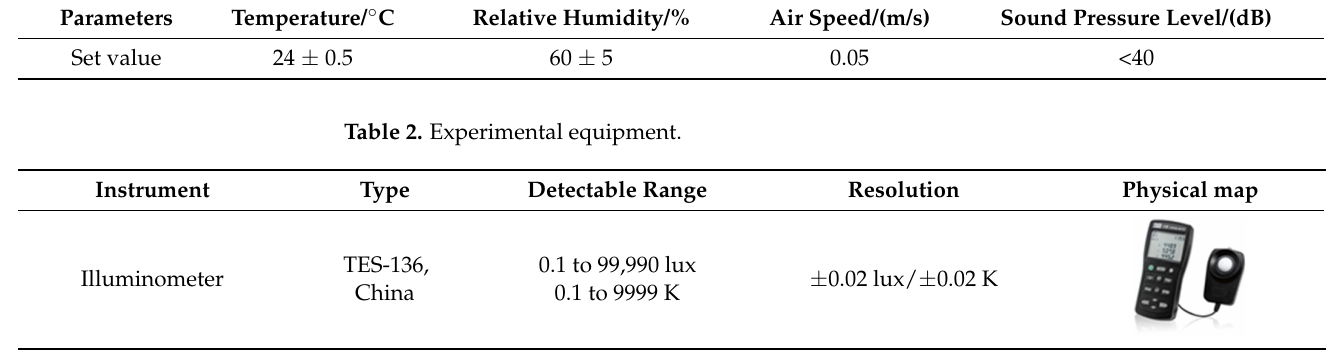
Table 1. Environmental parameter settings.